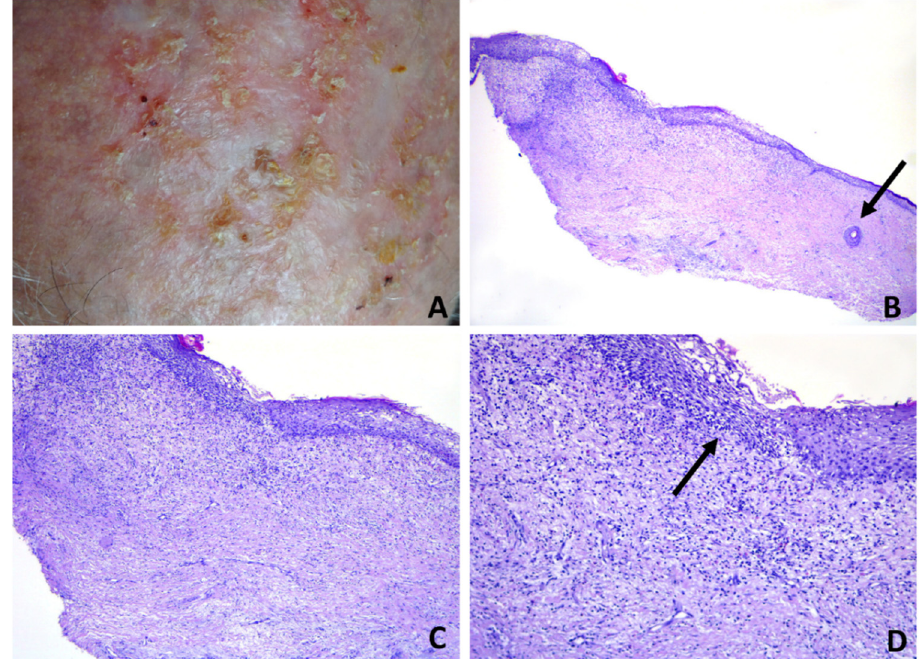
Figure 6. Erosive pustular dermatosis of the scalp; ( A ) tiny erosions, scale crusts and scarring. Pustules are barely detectable; ( B ) diffuse dermal fibrosis. A miniaturized hair follicle at the right lateral margin is seen (arrow); ( C ) dermal inflammatory infiltrate of lymphocytes and neutrophils; ( D ) intraepidermal spongiform pustule (arrow).